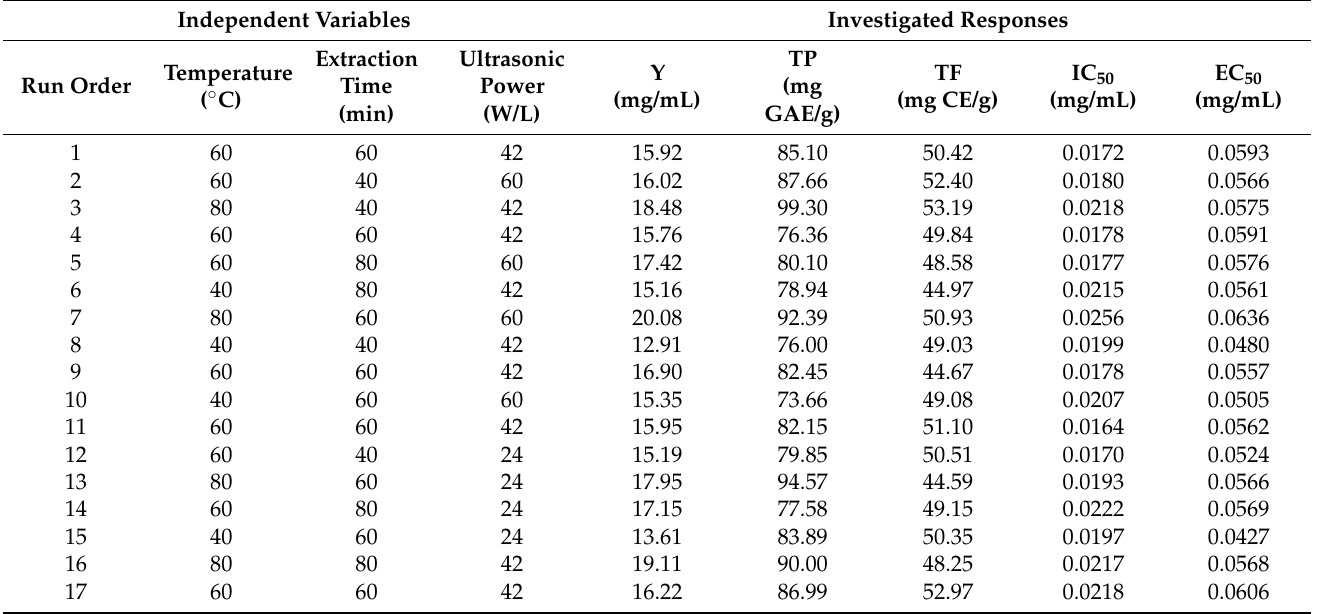
Table 1. BBD matrix with natural UAE parameters and experimentally observed values of TP, TF, IC 50 and EC 50